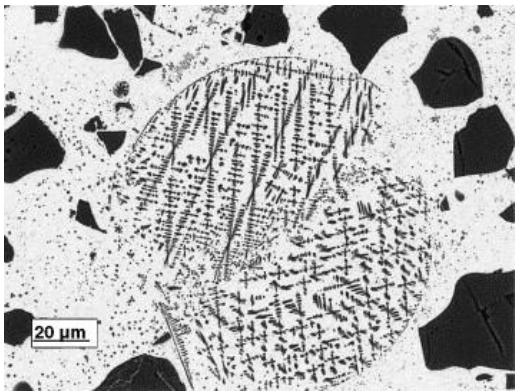
Figure 7. SEM of Invar36–30 wt.% TiC composite materials by DMLS p. Dark phase corresponds to TiC particles and bright to the Invar36 matrix. Reproduced from [51], with permission from Elsevier, 2006.